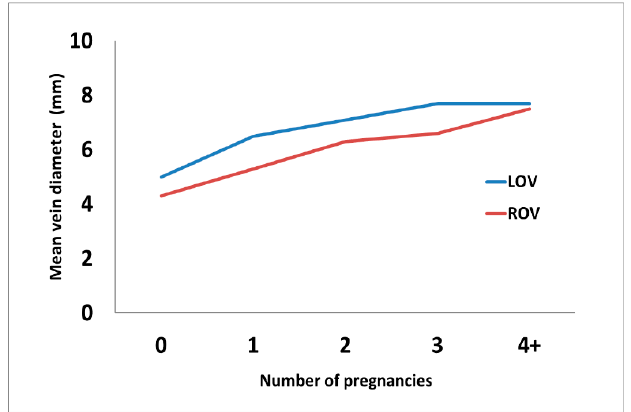
Figure 1. The graph shows the mean diameter (in mm, vertical axis) of both ovarian veins with regard to the number of pregnancies (horizontal axis). Abbreviations: LOV: left ovarian vein, ROV: right ovarian vein, and “4+”: 4 or more pregnancies. Table 2. Association of selected morphological parameters of abdominal/pelvic veins with the number of pregnancies (P). Parameter or Variable Whole Group P0 P0 AM P1 P2 P3